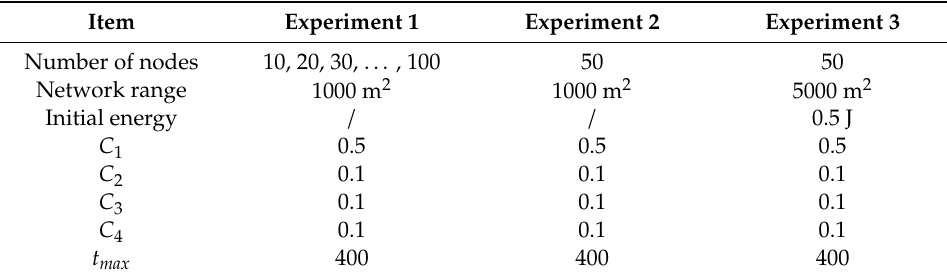
Figure 5. Optimal path in network topology. Table 2. Parameter-setting in experiments.